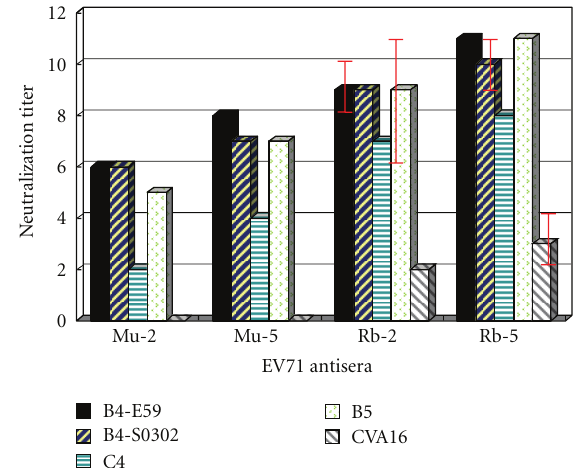
Figure 1: The average crossneutralization antibody titers (log 2 × 10) elicited by di ff erent amounts of inactivated EV71 virions in mice and rabbits. Mu-2, Mu-5, Rb-2, and Rb-5 are antisera obtained from mice (pooled sera from 3 immunized mice) and rabbits (2 rabbits) immunized 3 times with 2 or 5 µ g of inactivated EV71 vaccine candidate formulated with alum as adjuvant. The name code of each virus isolate is described in Materials and